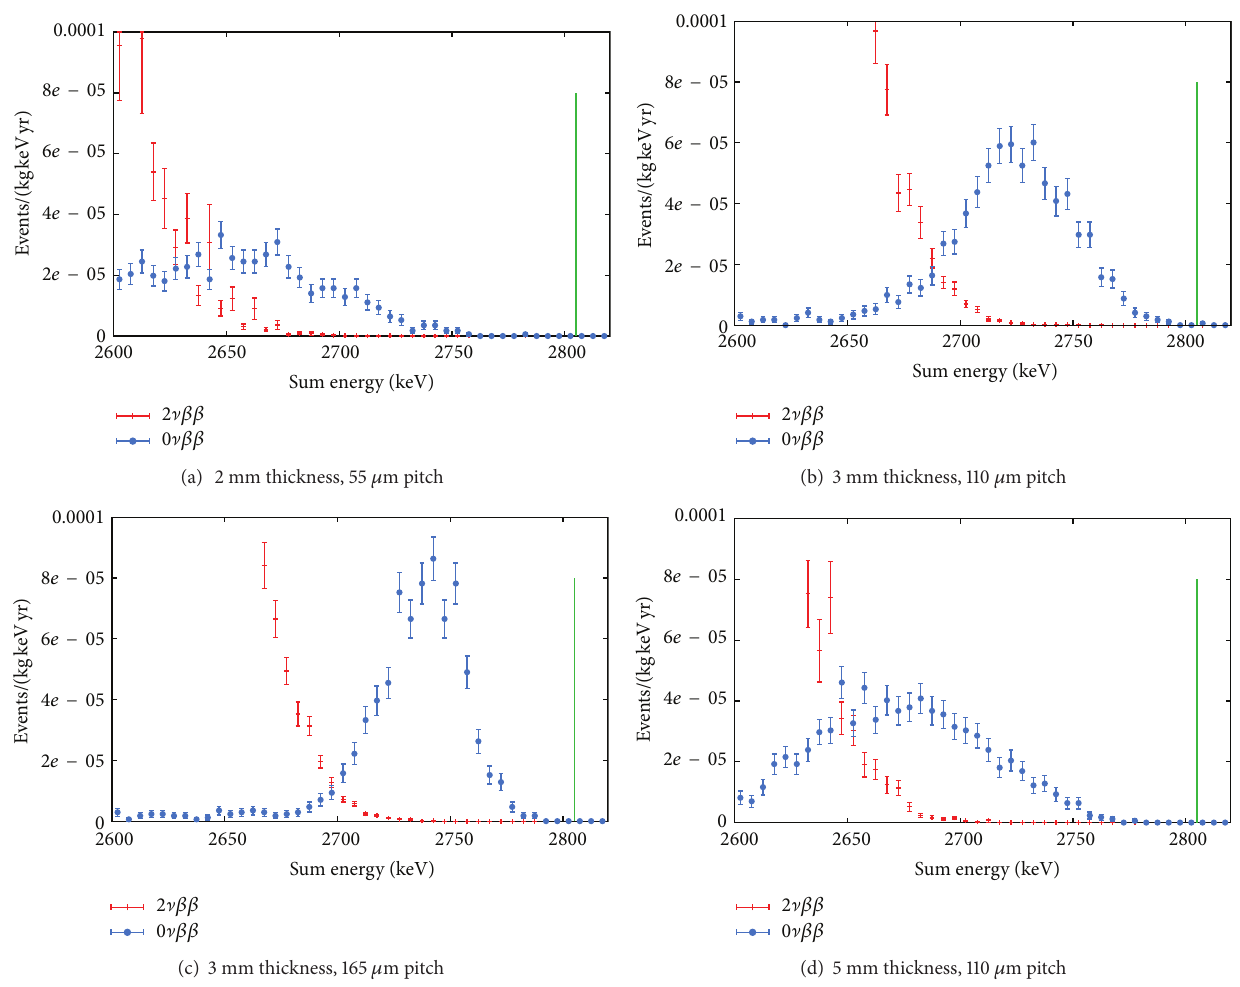
Figure 6: Simulated spectra of the total energy given in number of events per kg × keV × yr for 0 ] 𝛽𝛽 - (blue) and 2 ] 𝛽𝛽 -decays (red). Cadmium was assumed to be enriched to 90% in 116 Cd. The green vertical line indicates the position of the Q- value of the decay. The shifts of the peak positions for 0 ] 𝛽𝛽 -decays to deposited energies smaller than the Q- value is due to charge sharing at the edges of the electron tracks. 𝑇 2 ] = 2.88 × 10 19 yr [14] were assumed. The 1/2